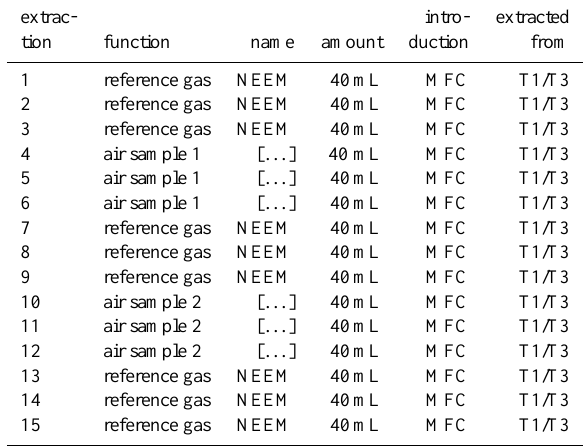
Table 2. Measurement sequence for ice core samples. A sequence Table 3. Measurement sequence for air samples from flasks or for two ice core sample measurements comprises 11 extraction mea- tanks. The presented sequence is used for triplet measurements of surements. Column 2 describes the function of each extraction. Col- two samples, bracketed by reference gas triplets. Column 2 de- umn 3 and 4 show the name and amount of the extracted sample, scribes the function of the measured gas, which is described and while column 5 specifies the way the samples are introduced and quantified in column 3 and 4, respectively. Column 5 indicates that column 6 shows from which analytical component the respective all samples are injected through the mass flow controller (MFC) di- sample is extracted, where MV stands for melt vessel. rectly into T3 or to be extracted from T1, as indicated in column 6. extracted extrac- intro- extracted tion